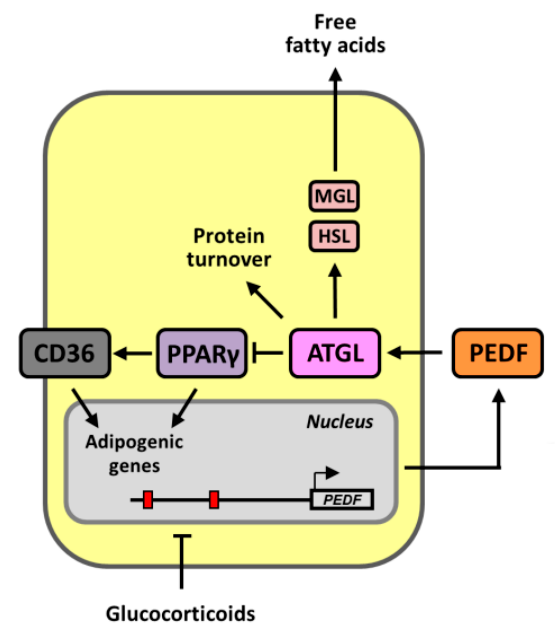
Figure 7. Schematic representation demonstrates the functional roles of PEDF in adipogenic differentiation. PEDF inhibits adipogenic differentiation via its binding partner ATGL (a hydrolase that breaks down triglycerides to release free fatty acids), suppressing PPAR γ activity and its downstream adipogenic gene expression. PEDF also down-regulates CD36, which itself is a downstream target of PPAR γ , and involved in adipogenesis. Furthermore, PEDF regulates ATGL levels by promoting its protein turnover, which may be part of a feedback mechanism. HSL, hormone-sensitive lipase; MGL; monoglyceride lipase.